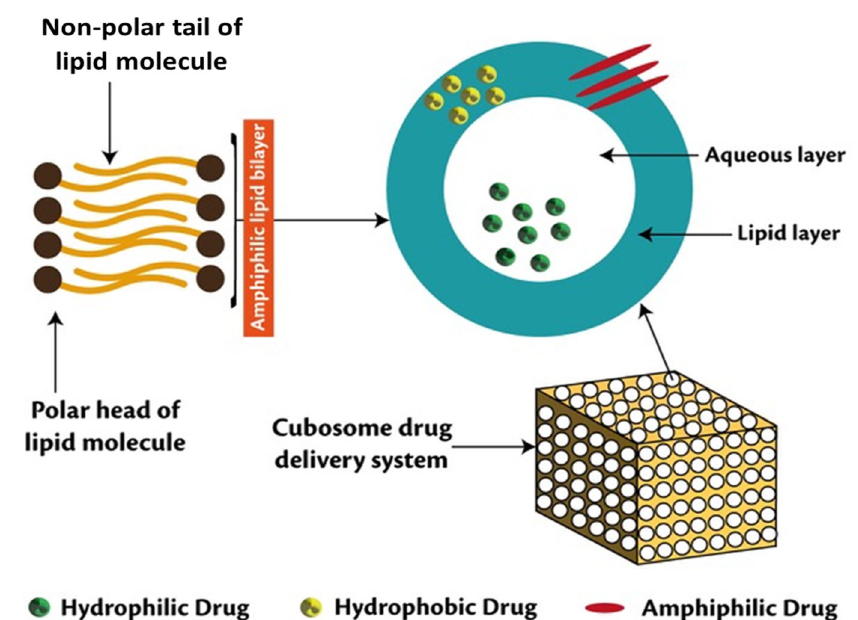
Figure 2. Primary structural components of cubosomes.